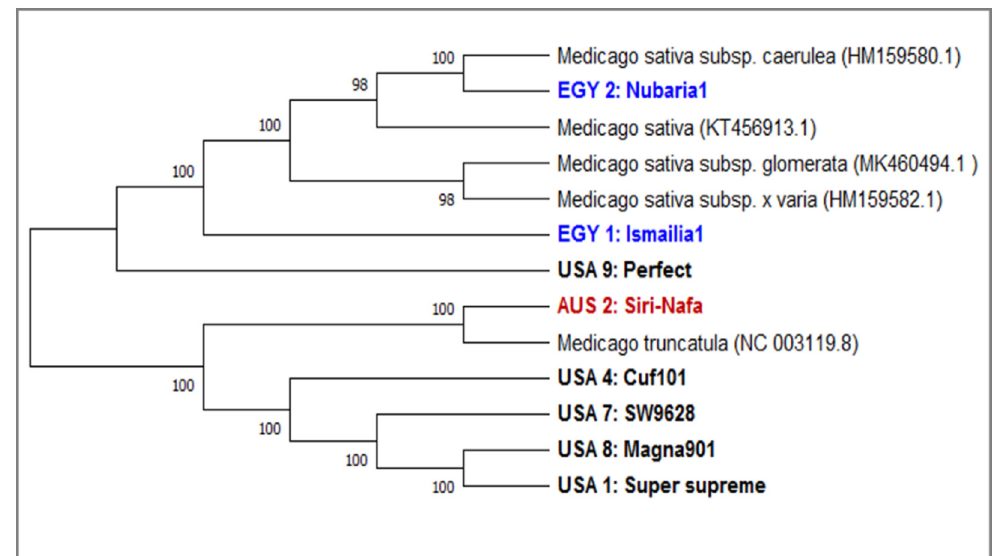
Figure 5. A consensus phylogenetic tree constructed based on the mat K DNA barcoding region for nine M. sativa cultivars using the MEGAX software. An additional three sequences of M. sativa L. mat K sequences were used as outgroups. The tree has a branch length of 2.8667 and the bootstrap values shown next to the branches indicate the bootstrap value supporting this node. The evolutionary distances were computed using the Jukes-Cantor method based on base substitutions per site. The ambiguous pairwise deletion option was used.